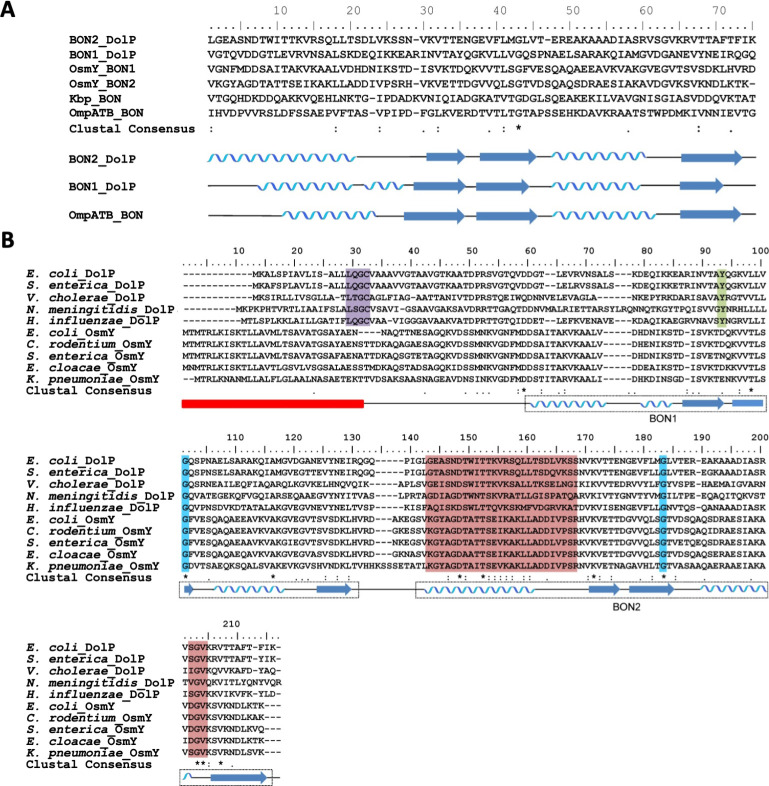
Alignment of DolP sequences from diverse proteobacterial species.(A) The amino acid sequences of the experimentally derived BON domains of DolP and OmpATb are aligned with the predicted amino acid sequences of the BON domains from Kbp and OsmY. The position of the experimentally derived secondary structure for DolP BON1 and BON2 and OmpATb are depicted below the sequence alignment. (B) Alignments of the amino acid sequences of DolP and OsmY from various Gram-negative bacteria. The positions of the experimentally-derived secondary structural elements of E. coli DolP are depicted below the sequence alignment. The signal sequence is depicted by the red box. The Lipobox associated with recognition by LspA and acylation is highlighted in purple. The conserved glycine residues are highlighted in blue and the tyrosine residue associated with interdomain interactions is highlighted in green. Residues showing CSPs are highlighted in pink.